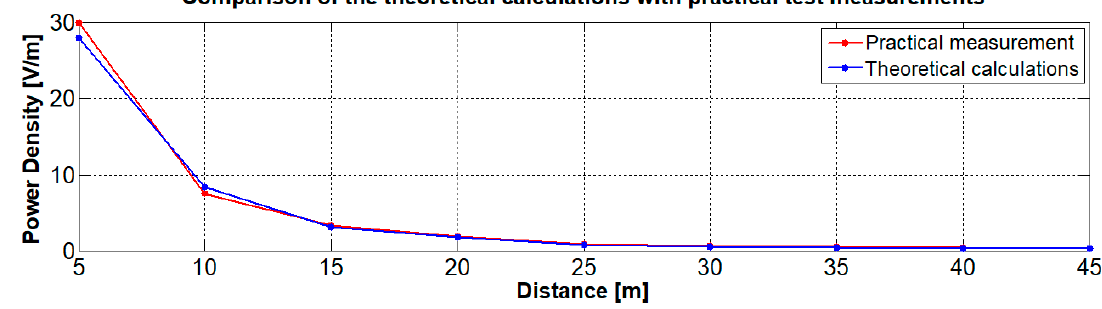
Figure 16. Comparison of the theoretical calculations with practical test measurements.